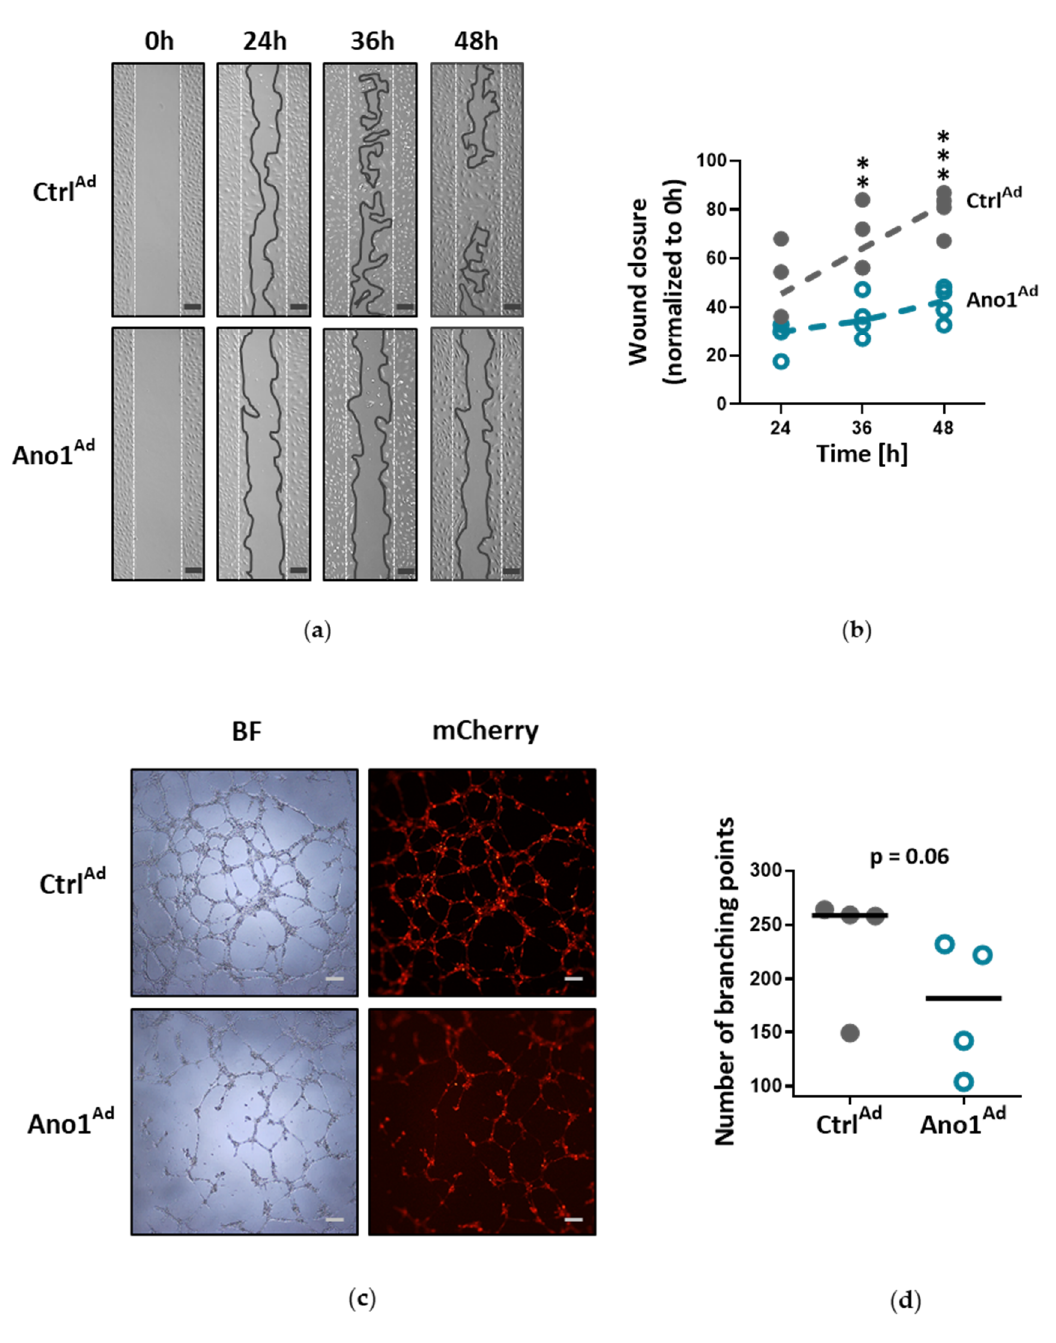
Figure 6. Increased TMEM16A activity causes angiogenic dysfunction. ( a ) Representative pictures of PAECs wound healing assay, expressing either Ano1 Ad or control Ctrl Ad , taken after 24, 36 and 48 h (scale bar = 200 µ m). ( b ) Quantification of the wound healing assay. ( c ) Matrigel tube-formation assay with representative bright-field (BF) and mCherry fluorescence pictures of Ano1 Ad or Ctrl Ad -infected PAECs (scale bar = 200 µ m). ( d ) Quantification showing the number of branching points in comparison to Ctrl Ad . Figures were generated with 4 separate sets of experiments with triplicate in each group. ** p < 0.01, *** p < 0.001, ( b ) ANOVA with Bonferroni post-hoc test, ( d ) paired t-test.